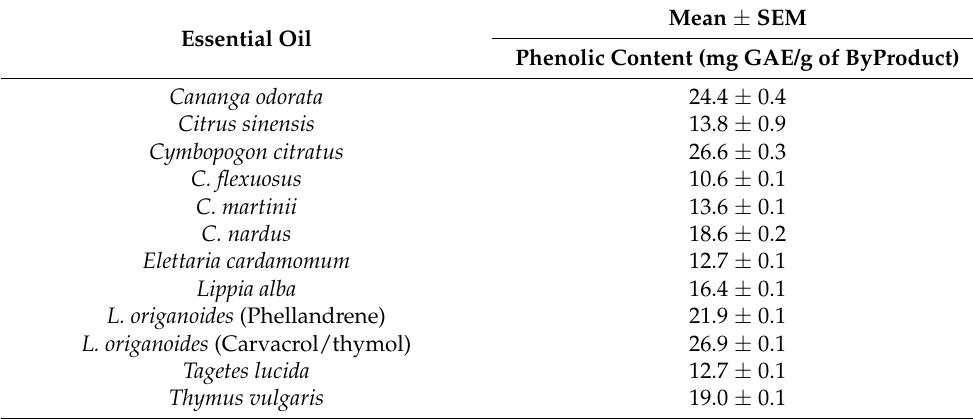
Table 1. Quantification of total phenolic content in essential